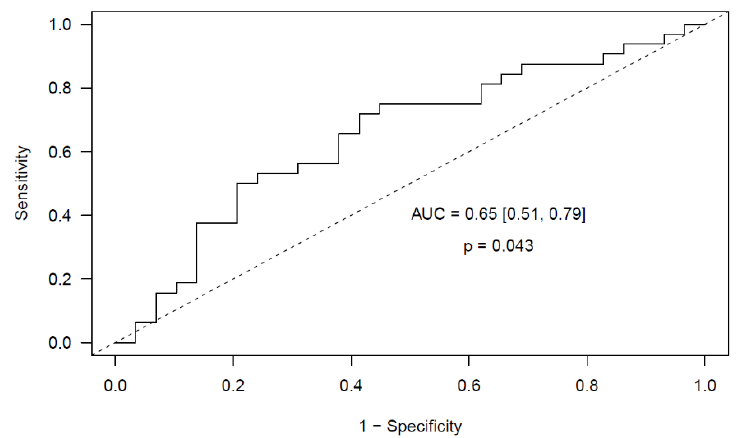
Figure 5. Validated ROC curve of the multivariable elastic net predictive model for ccRCC that